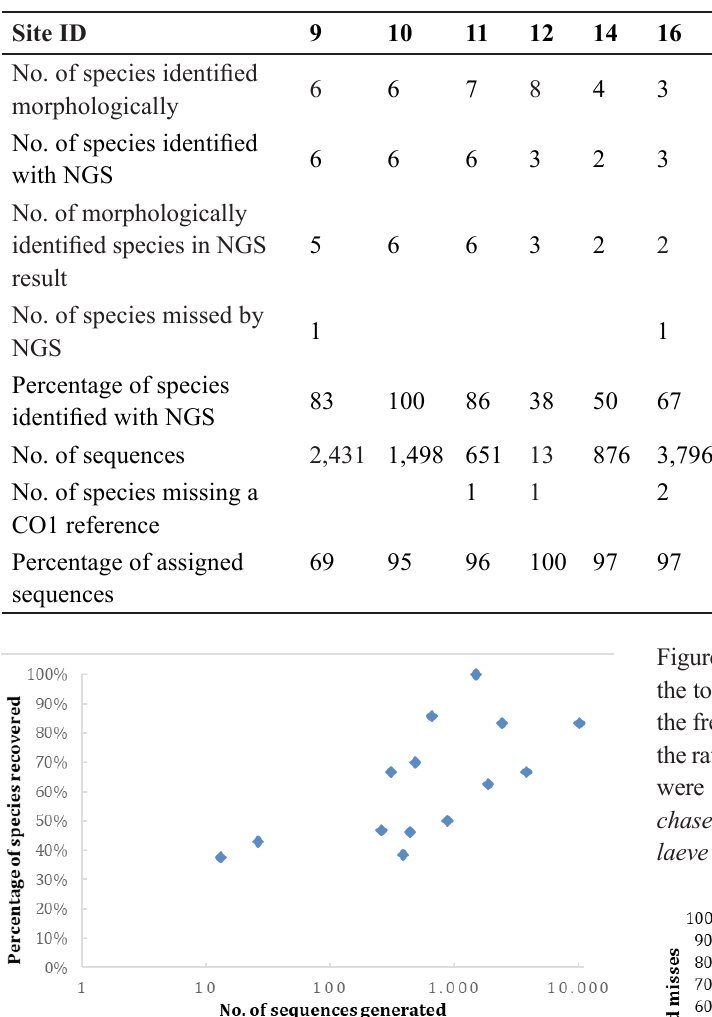
Table 4 . Overview of the NGS sequencing data, including the number of species present at each site and whether they were recovered by NGS. Also shown are the outcomes of the NGS sequencing run output for each site, including the number of sequences that were assigned with > 95% similarity to a reference sequence.